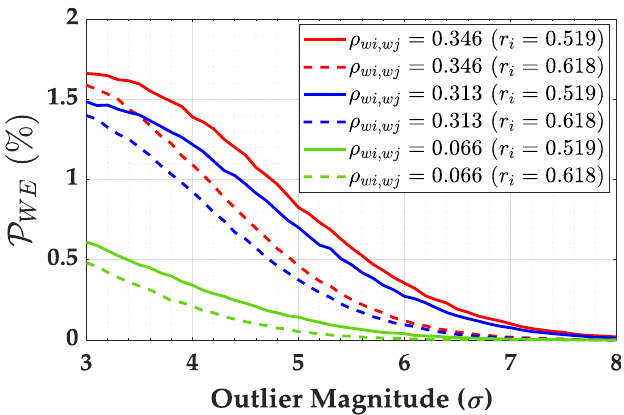
Figure 12. Individual contributions to the overall P WE for network ( a ) and their relationship with the redundancy number r i for residuals with the same correlation coefficient ρ w